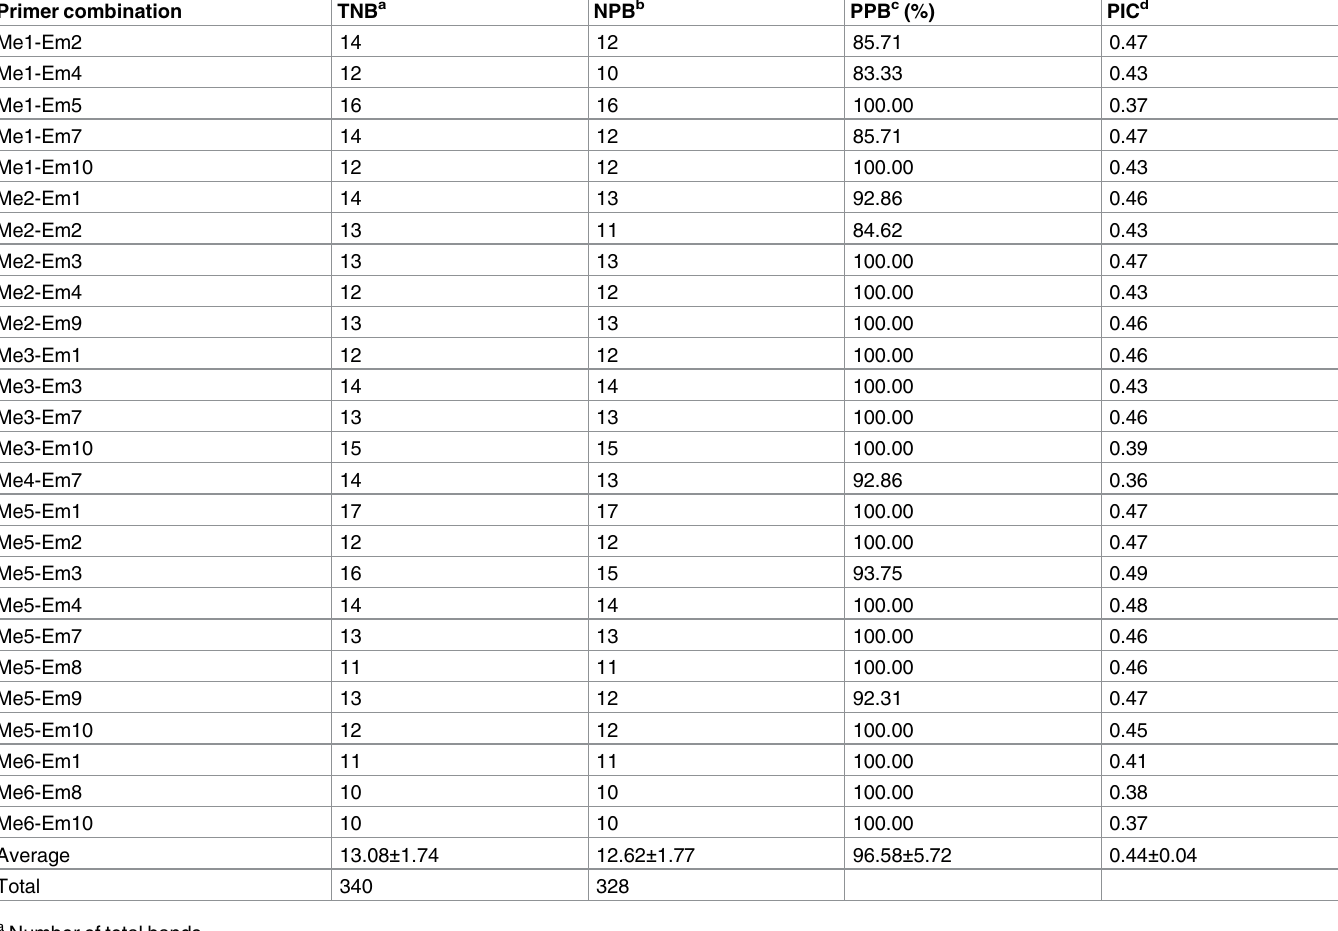
Table 3. Results of sequence-related amplified polymorphism (SRAP) markeramplification of the 157 bermudagrass accessions. Primer